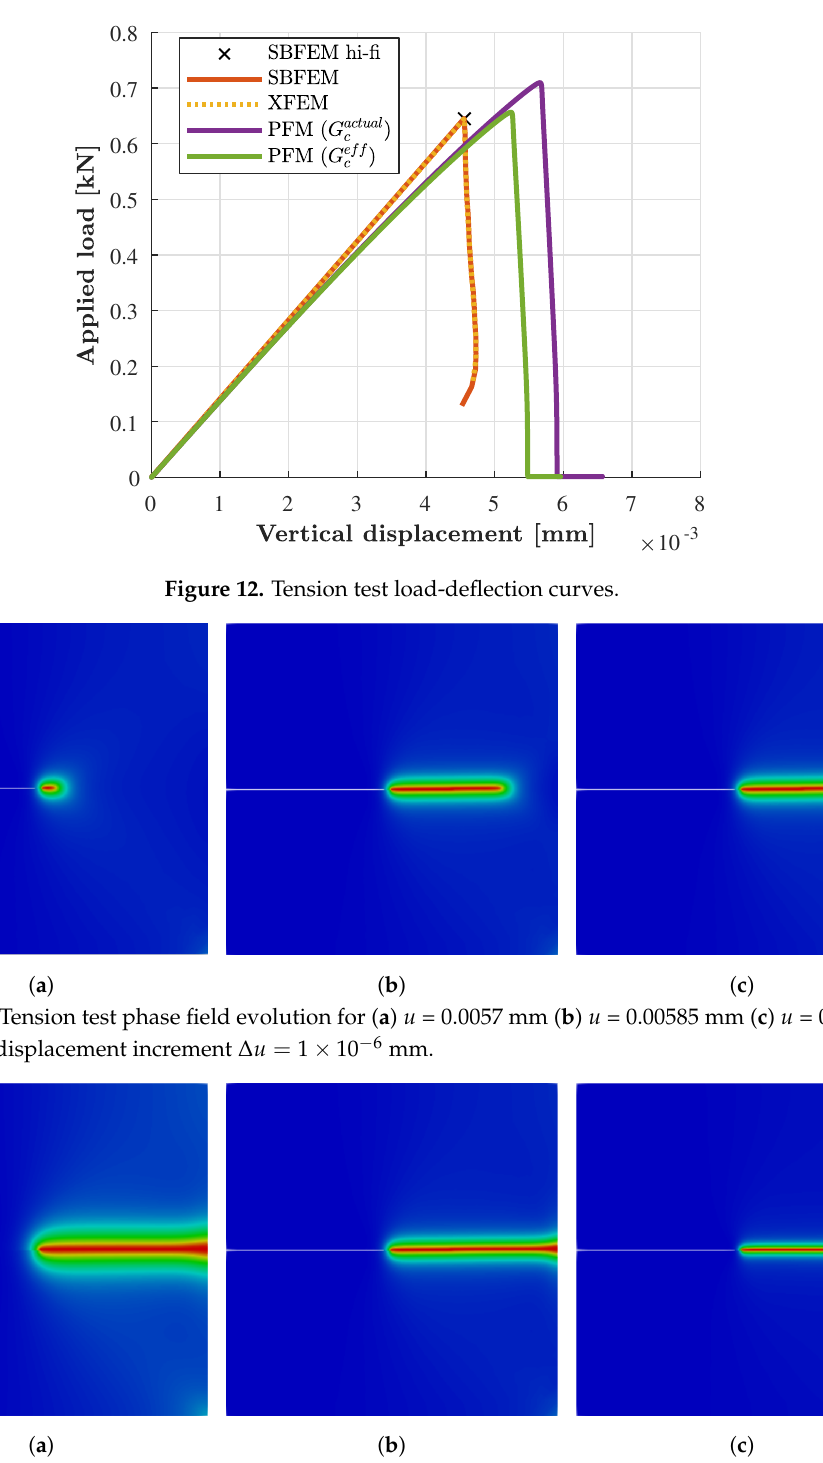
Figure 14. Tension test comparison of phase field diffusion widths employing ( a ) l o = 0.015 mm ( b ) l o = 0.0075 mm ( c ) l o = 0.00375